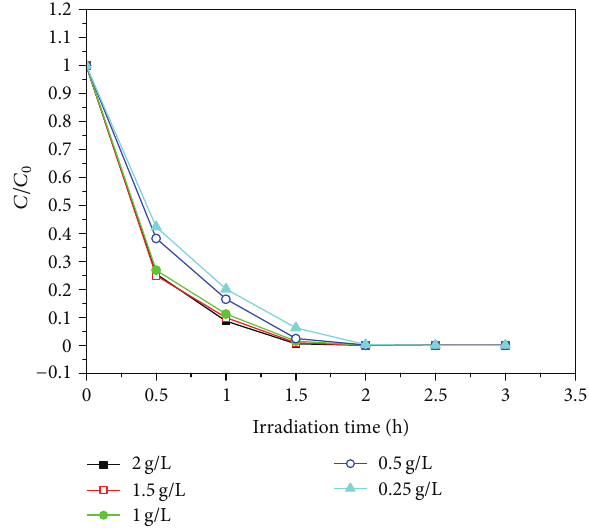
Figure 7: The photocatalytic activity of Fe-TNT-1 with different dosages under visible light